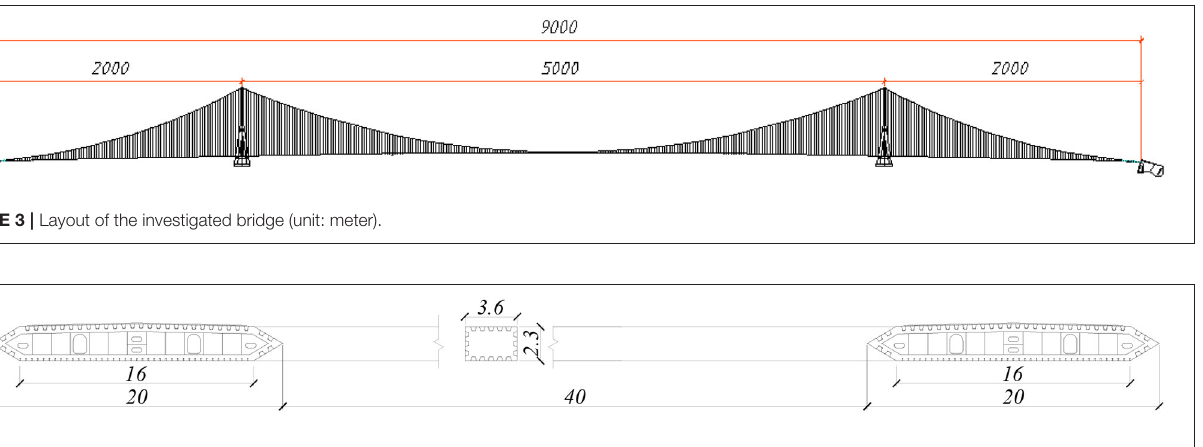
FIGURE 4 | Cross section of stiffening girder (unit: meter).